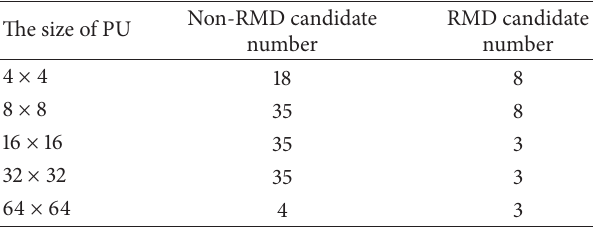
Table 4: Number of intra modes in 𝑆 RMD